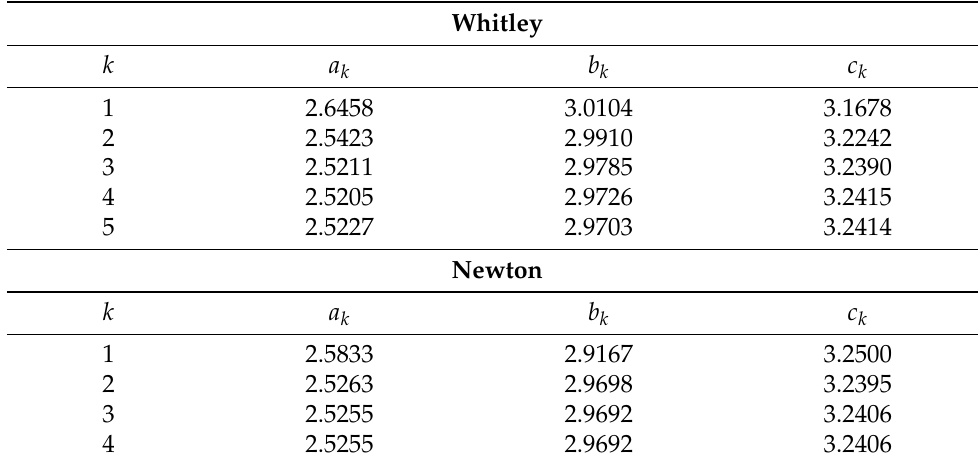
Table 1. Fixed-point iterations of Whitley and Newton’s